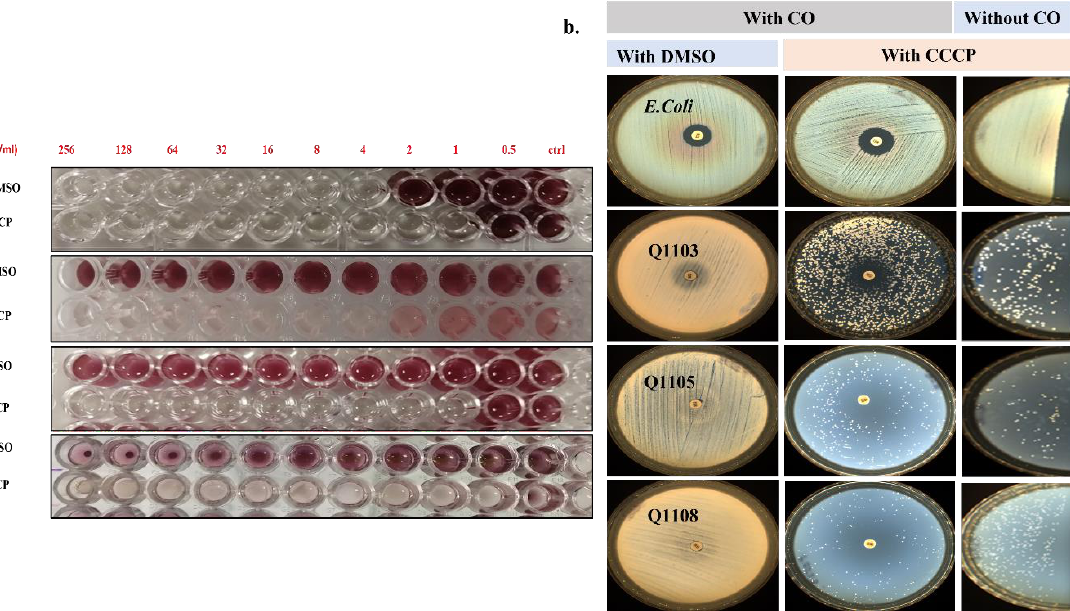
Figure 2. Observation of the effect of CCCP alone and in combination with CO using the liquid method ( a ) and the agar method ( b ) on tested Brucella strains. ( a ): CO-MIC determination by the microdilution method with and without CCCP (10 µg/mL). ( b ): Left two columns, CO inhibition diameter on CAMH plates containing 0.2% DMSO or CCCP (10 µg/mL); right column, growth of